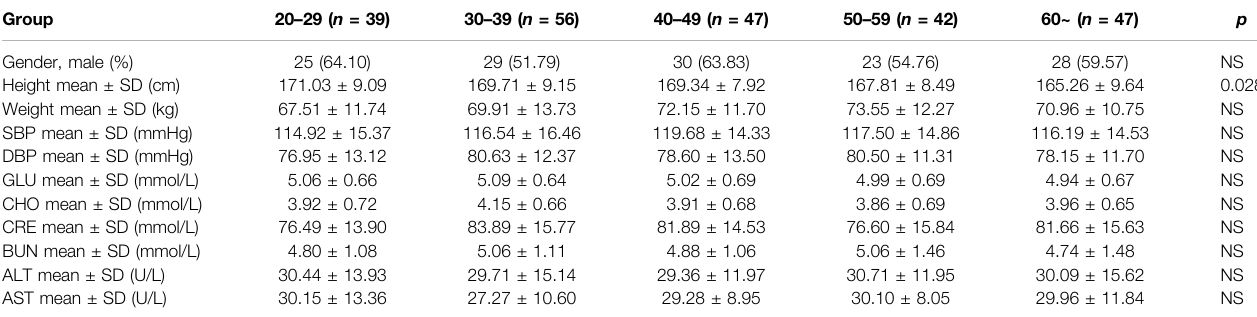
TABLE 1 | Characteristics of 231 healthy